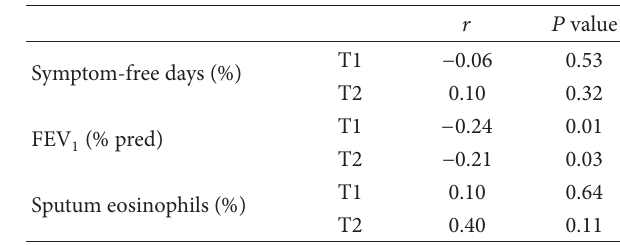
T 3: Correlations between the changes from baseline in uEPX and changes in clinical markers of asthma control.